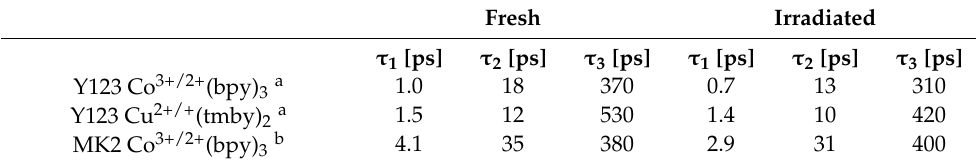
Figure 4. Results of the global analysis of transient absorption data using a three-exponential function with a constant offset for DSSC with Y123 dye and ( A ) cobalt- and ( B ) copper-based electrolyte after 30 min irradiation (compare with Figure 1) and DSSC with MK2 dye and cobalt-based electrolyte before ( C ) and after ( D ) irradiation. Table 3. Comparison of time constants obtained in the global analysis of transient absorption measurements conducted before and after irradiation and shown in Figures 4, S5 and S6.